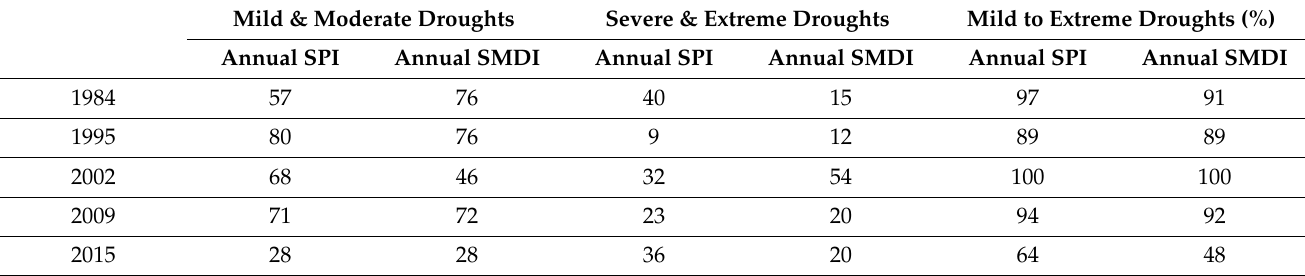
Table 3. Percentages of areas under drought condition during the selected historic drought episodes for an annual aggregate period.